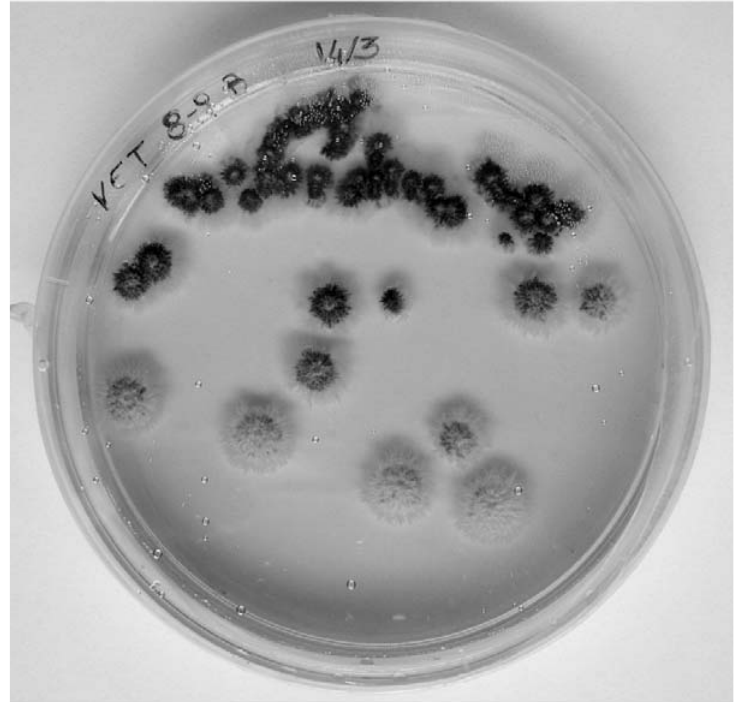
Fig. 6. Trapped Phaeomoniella chlamydospora growing on malt agar added with 0.1 g l -1 tetracycline-HCl.